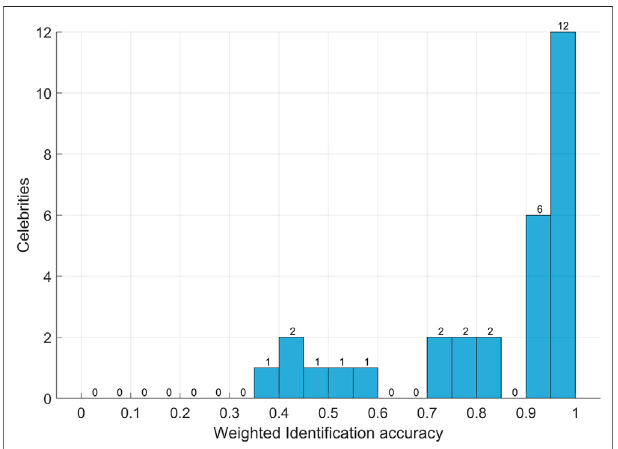
FIGURE 5 | Histogram of the accuracy score achieved for all celebrities, obtained by weighted averaging the accuracies in F A and F B .